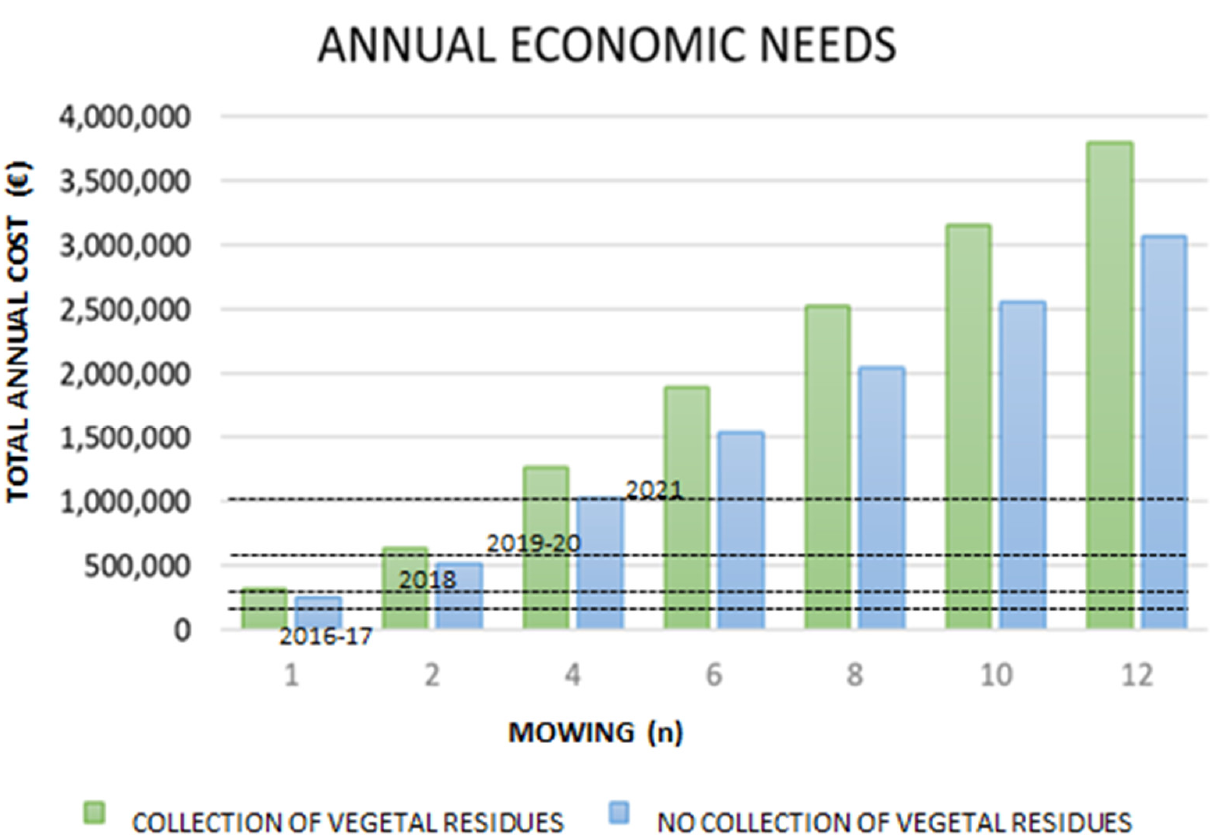
Figure 6. Comparison between the economic requirements for grass mowing with and without the collection of vegetal residues as a function of the number of interventions performed over a year. Horizontal dashed lines indicate the annual budget allocated by the Municipality for the maintenance of green public areas: ~255,000 € in 2016–17, ~377,000 € in 2018, ~600,000 € in 2019–20, and ~1 Ml € in 2021.